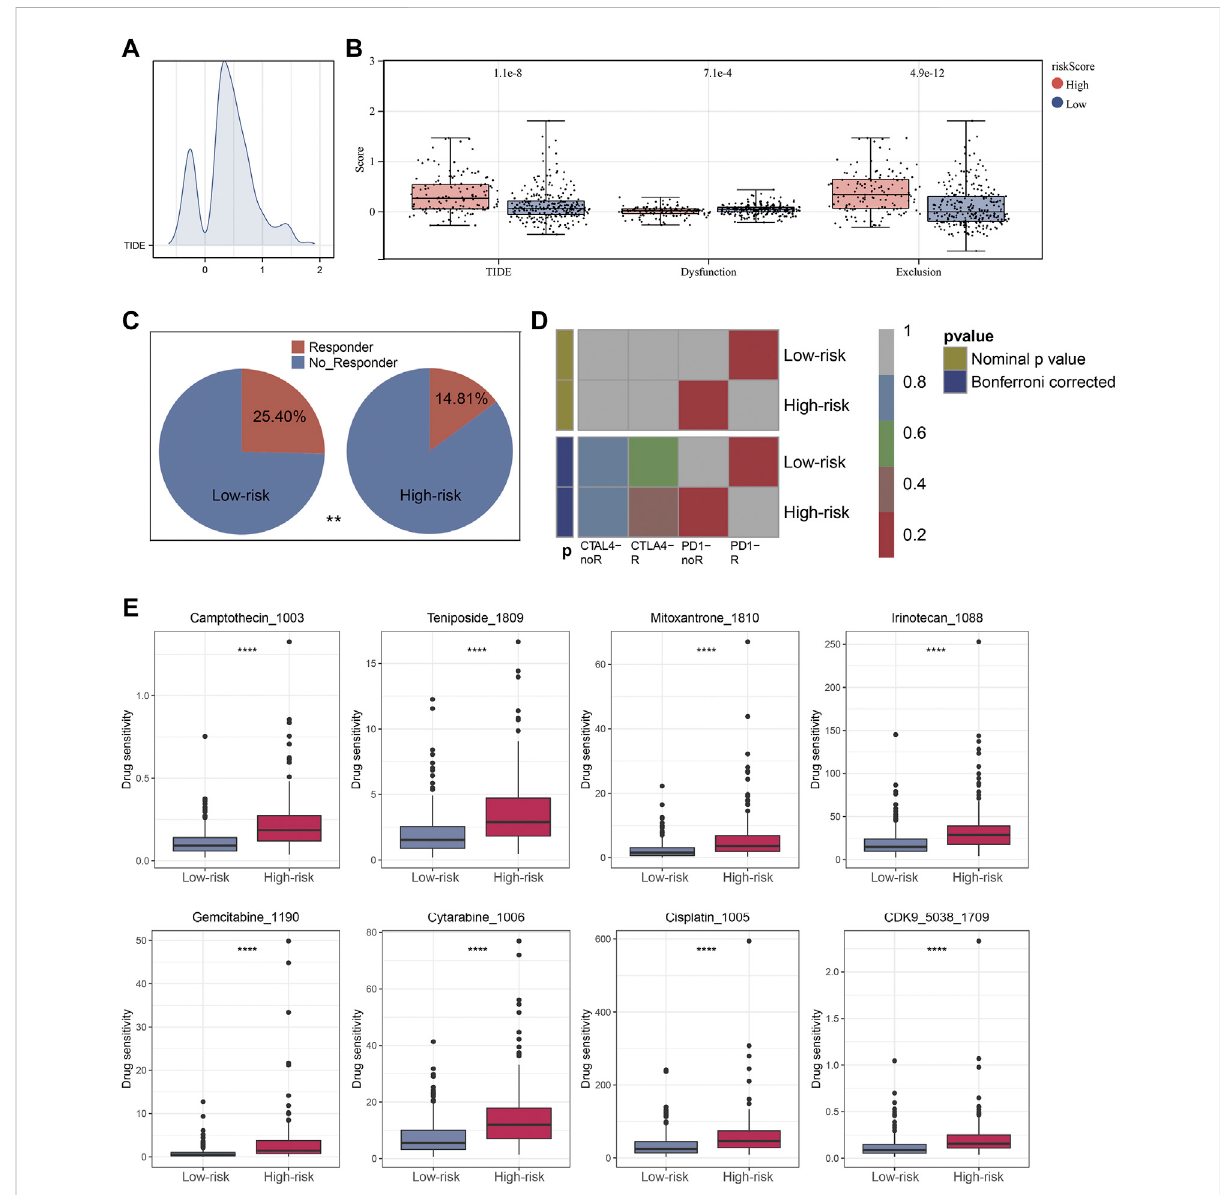
FIGURE 9 Immunotherapeutic response prediction and screening of potential drugs. Notes: (A) Distribution of TIDE score of each OSCC patient. (B) PatientsinlowriskgrouphavealowerlevelofTIDEscore,DysfunctionscoreandExclusionscore. (C) Immunotherapyhasahighersuccessratewith low-riskpatients. (D) Thesubclassmappinganalysisshowedthatlow-riskpatientsweremorelikelytobene fi tfromPD-1inhibitortherapy. (E) Thetop eight drugs with the maximum log2FC values and the minimum p values in GDSC